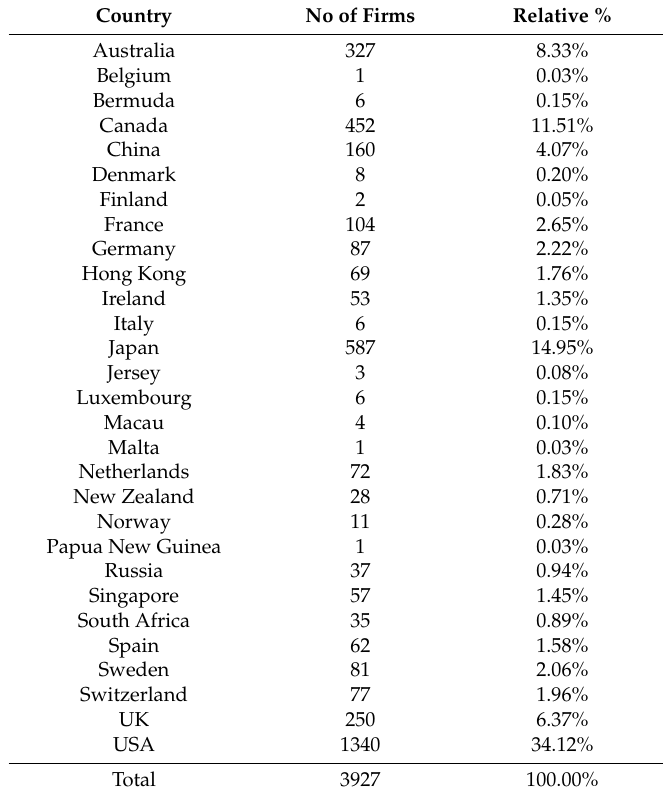
Table 4. Distribution of Firms by Countries.